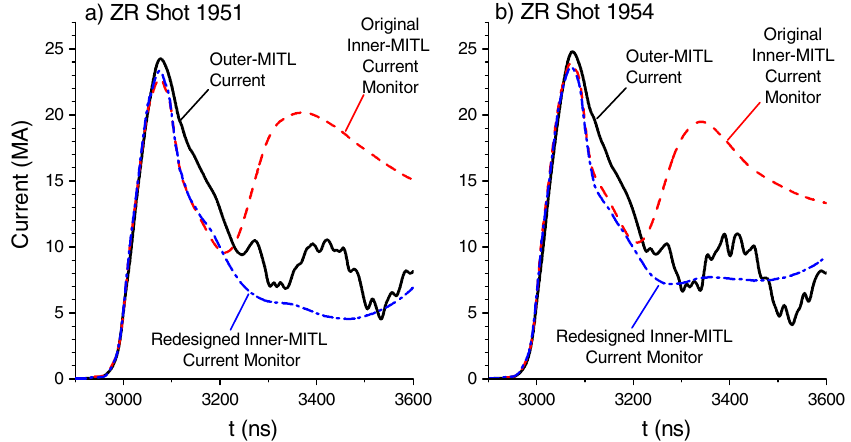
FIG. 8. (Color) Outer-MITL current (solid black line) and inner-MITL load-current measurements from two ZR shots with low- impedance dynamic hohlraum z -pinch loads. The current obtained from the original inner-MITL monitor design is shown as a red dashed line and the current obtained from the redesigned inner-MITL monitor is shown as a blue dash-dotted line.